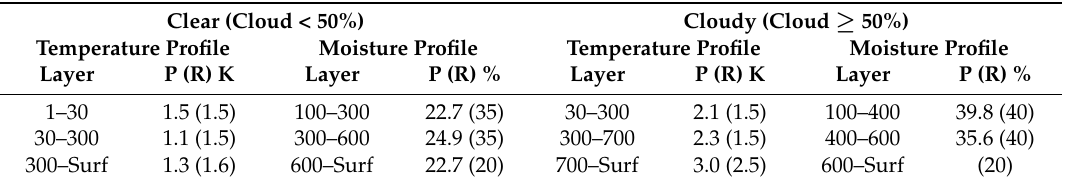
Table 10. S-NPP NUCAPS temperature/moisture profile performance and requirements *.